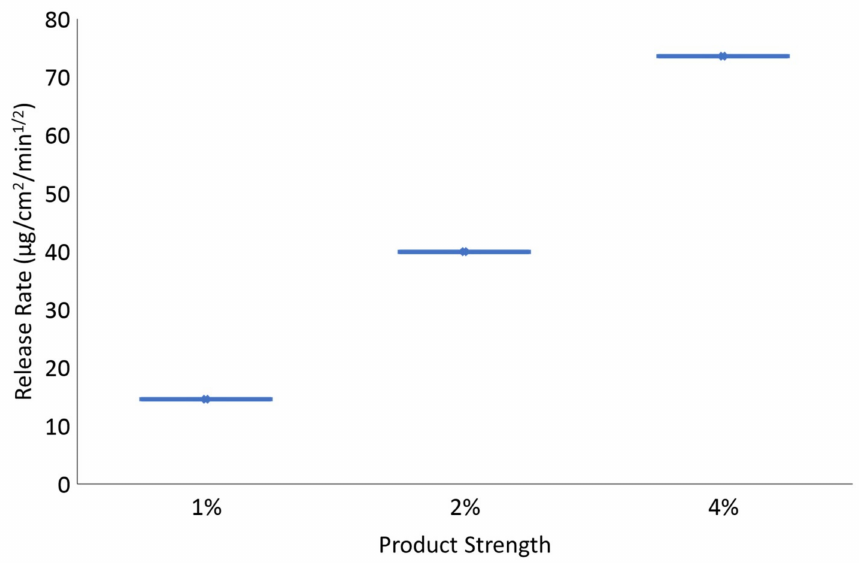
Figure 2. Box and Whiskers plot of the measured release rates for the three products containing